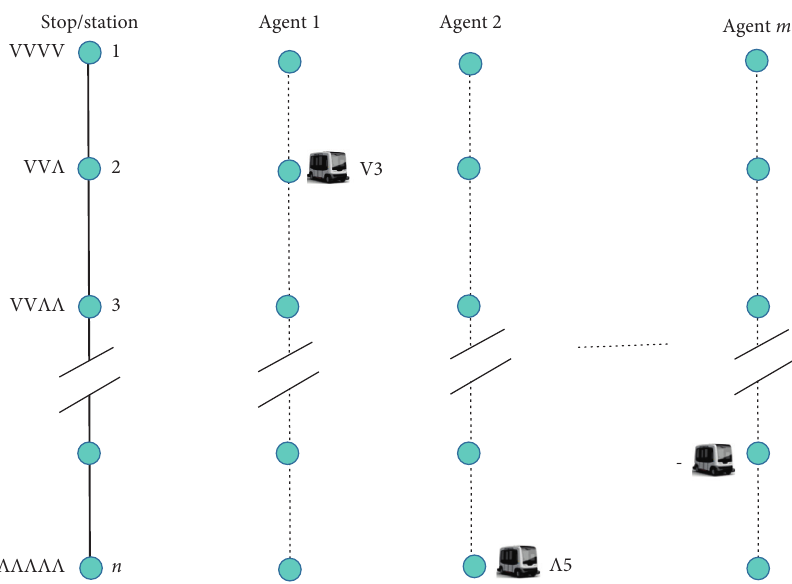
Figure 2: Schematic of the simulation